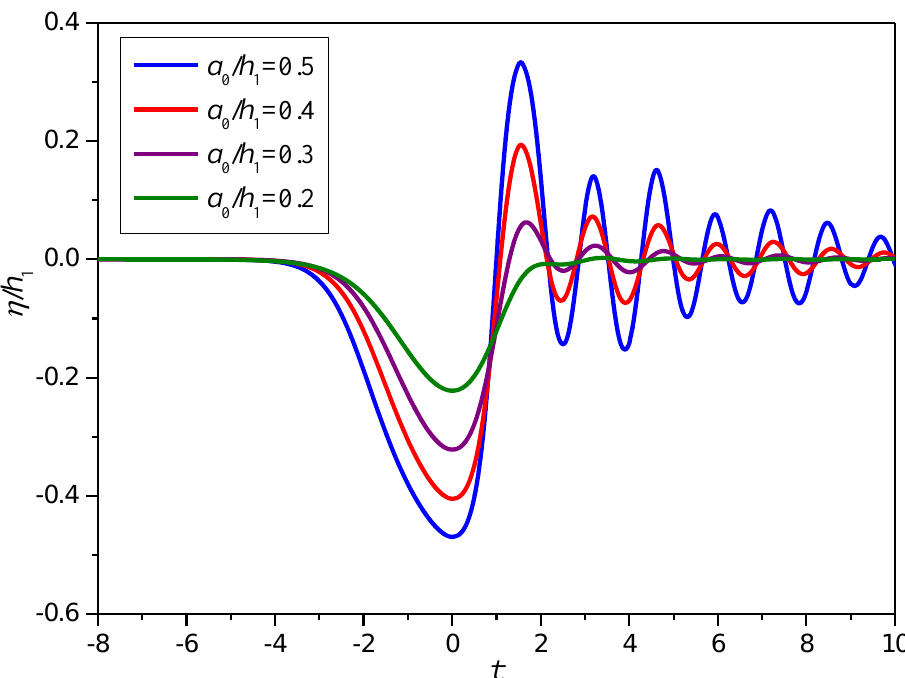
Figure 14. Characteristics of the tail waves under different slope height conditions.